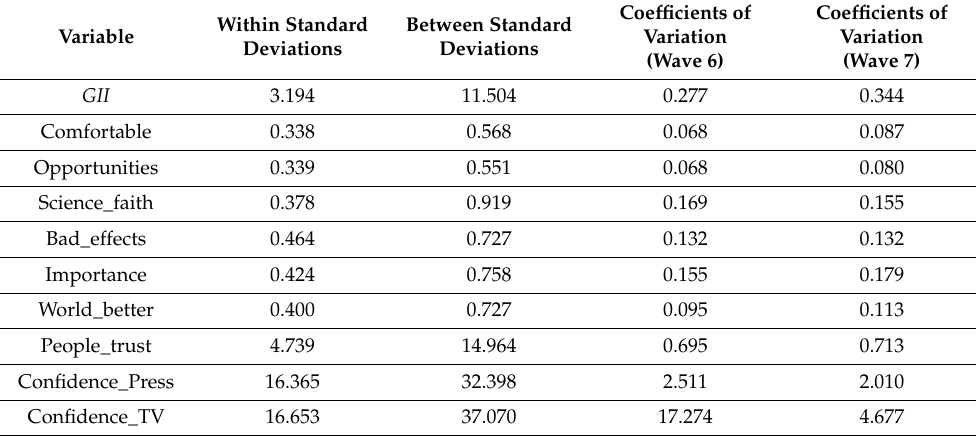
Table 3. Indicators of variation of